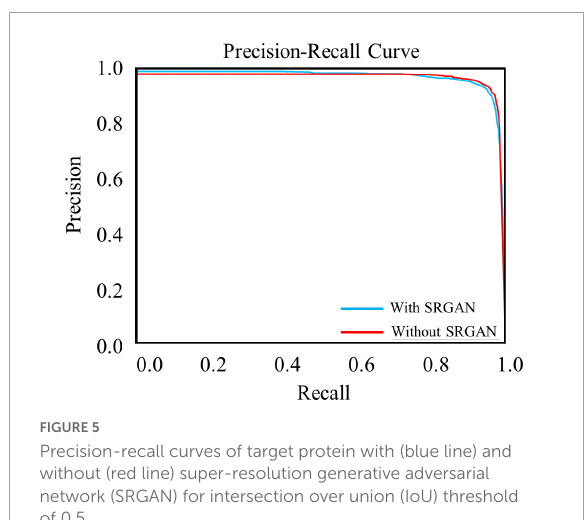
FIGURE5 Precision-recall curves of target protein with (blue line) and without (red line) super-resolution generative adversarial network (SRGAN) for intersection over union (IoU) threshold of 0.5.